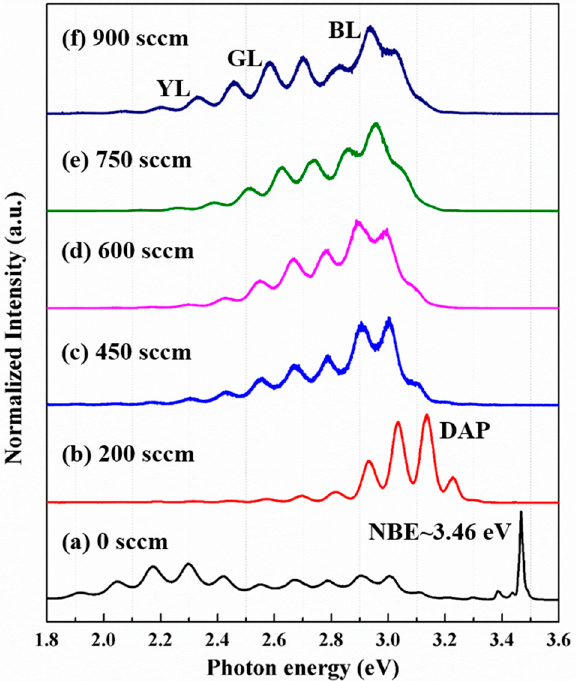
Figure 3. The low-temperature (10 K) PL spectra of p-GaN/AlGaN structures with varying Cp 2 Mg flow rates.